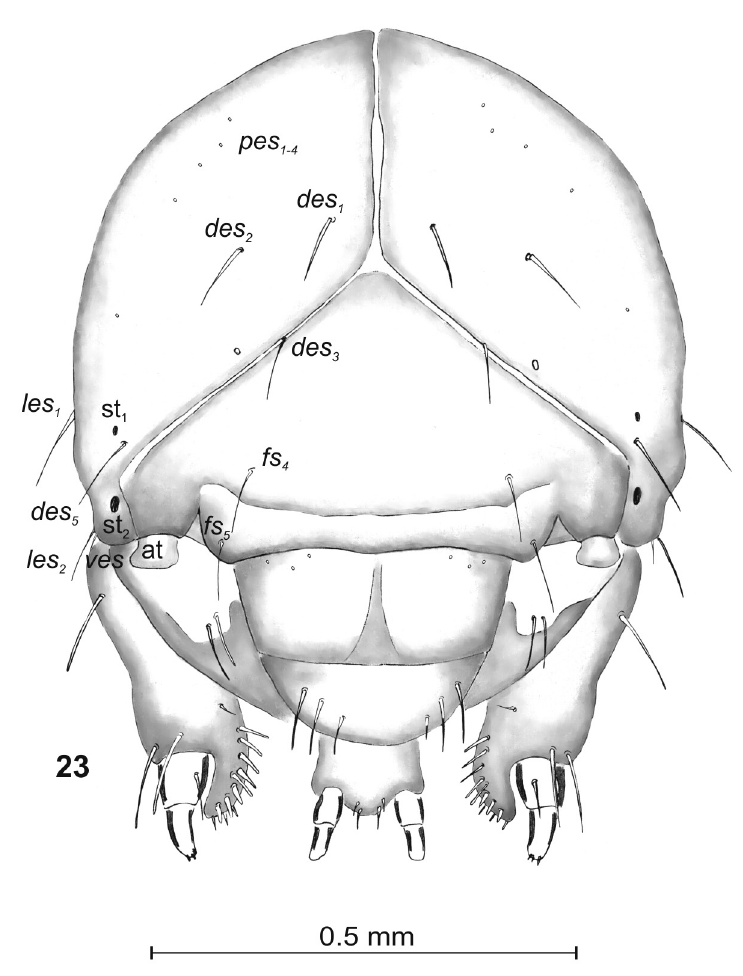
Figure 23. Strophosoma melanogrammum , mature larva, head. Abbreviations: at – antenna st – stemmata. Setae: des - dorsal